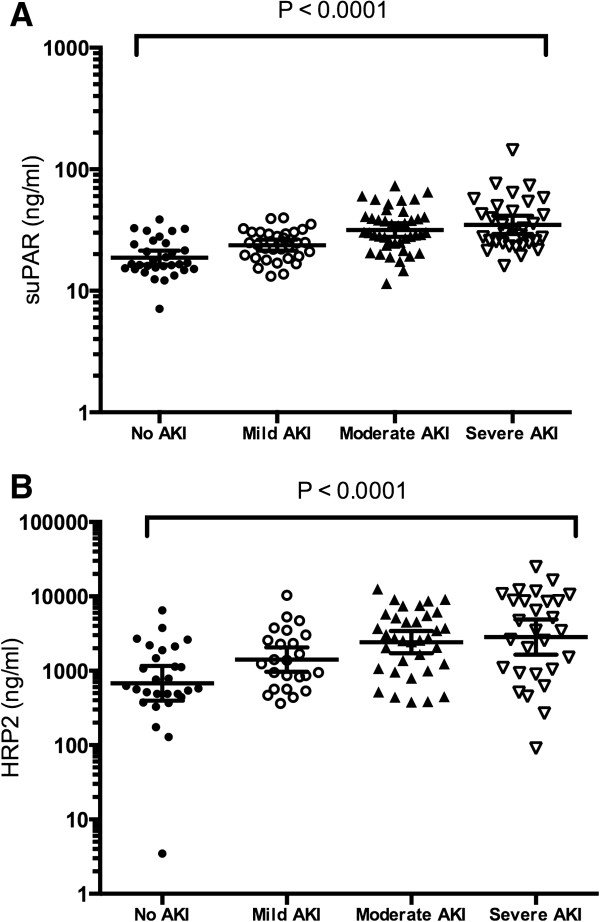
Scatterplots of cohort stratified by admission acute kidney injury severity. (A) Plasma soluble urokinase–type plasminogen activator receptor (suPAR), and (B) plasma HRP2 concentrations. Concentrations for both suPAR and HRP2 increased with increasing severity of AKI (test-for-trend P <0.0001). Geometric mean and 95% confidence intervals displayed. AKI = acute kidney injury; HRP2 = P. falciparum histidine rich protein 2.